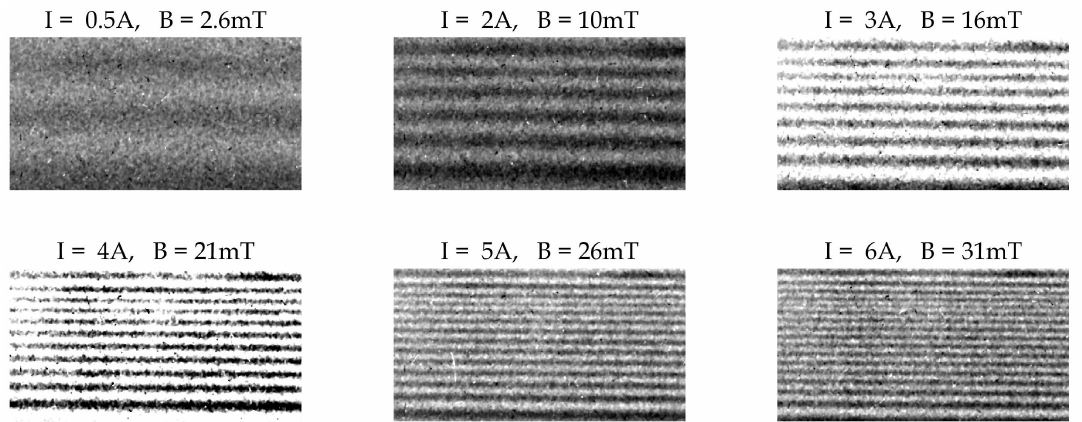
Figure 11. Radiography images of a magnetized coil due to path dependent depolarization of polarized neutrons. Fringe pattern occurs due to different path length in the quadratic coil, size = 566 × 296 pixel = 15.28 mm × 7.99 mm, exposure time = 5400 s, B = magnetic field in the coil, see fringe pattern of Figure